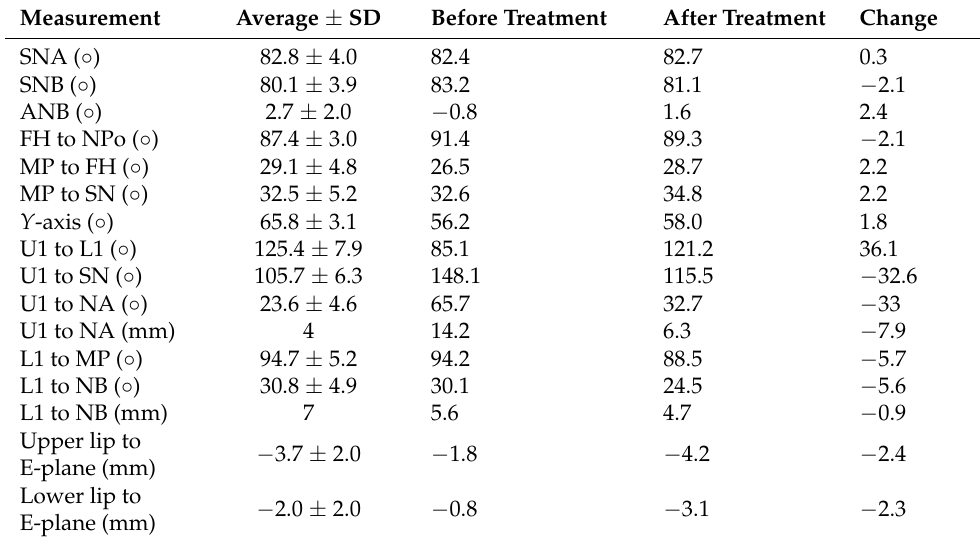
Table 1. Cephalometric analysis. Asian norms were used as the reference.